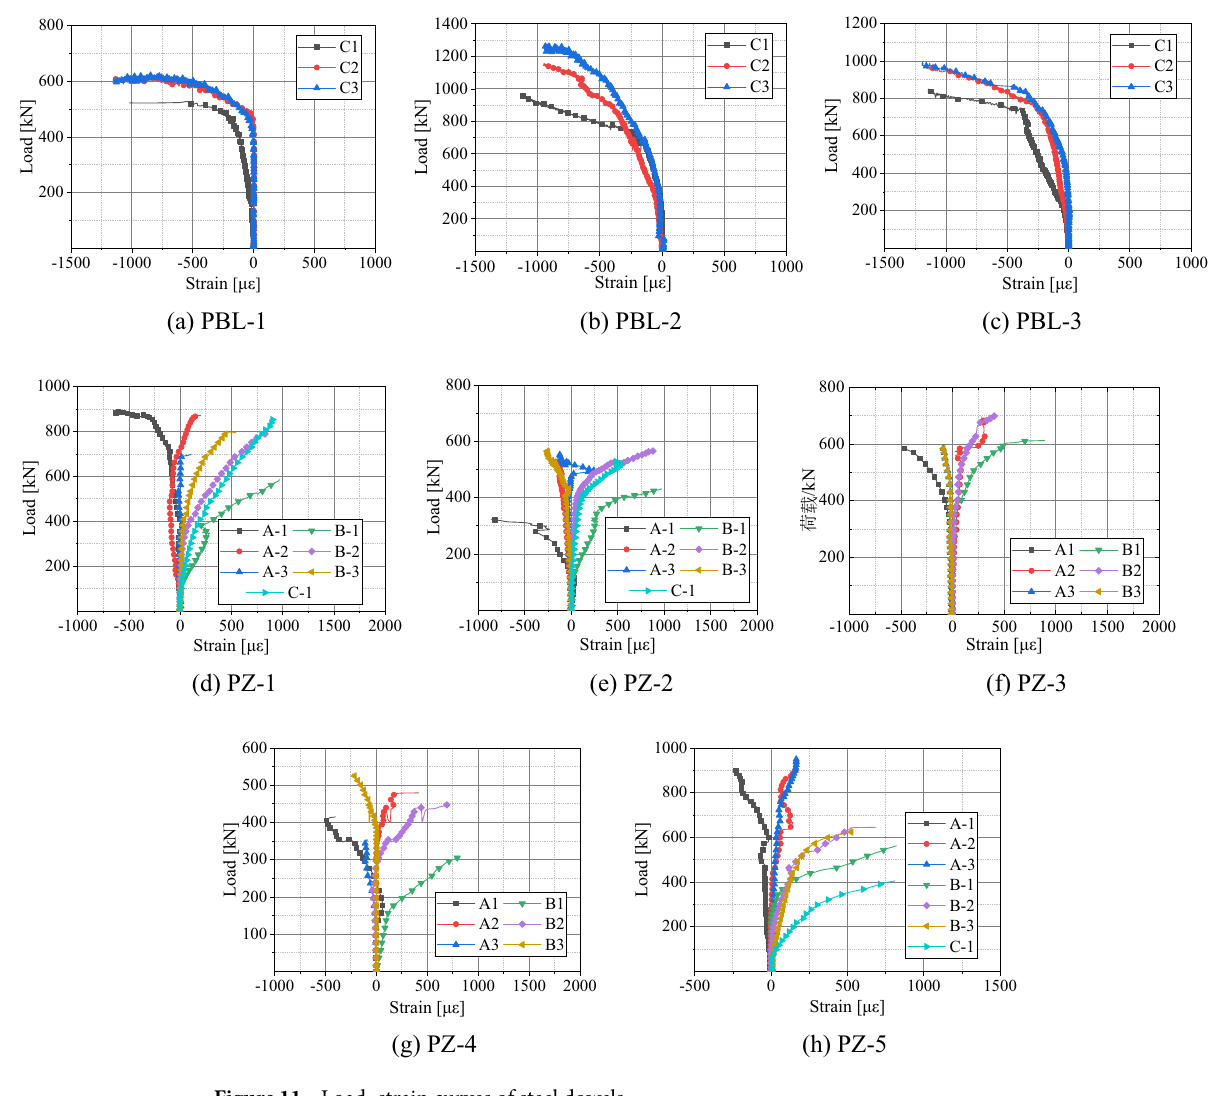
Figure 11. Load–strain curves of steel